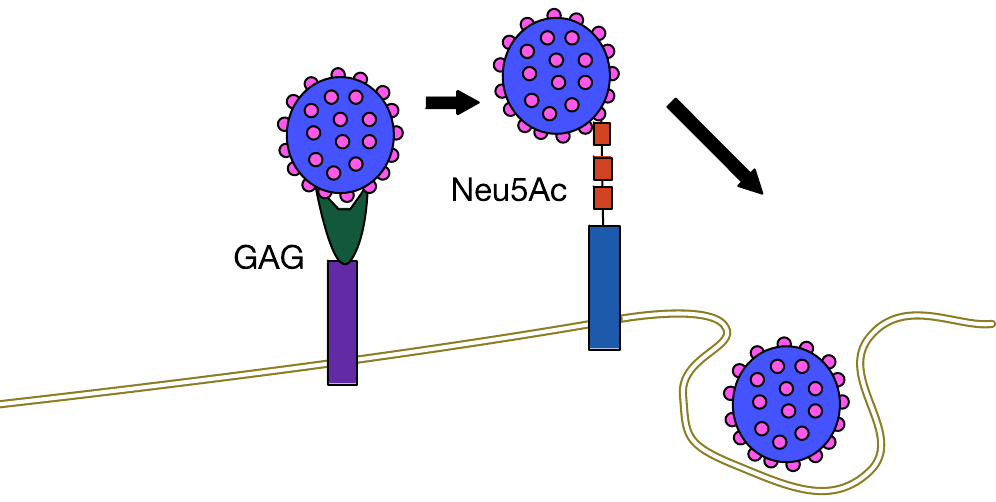
Figure 5. Two-step attachment and entry process of MCPyV. GAG—glycosaminoglycan, such as heparan sulfate. Neu5Ac—ganglioside with a linear Neu5Ac-α2,3-Gal